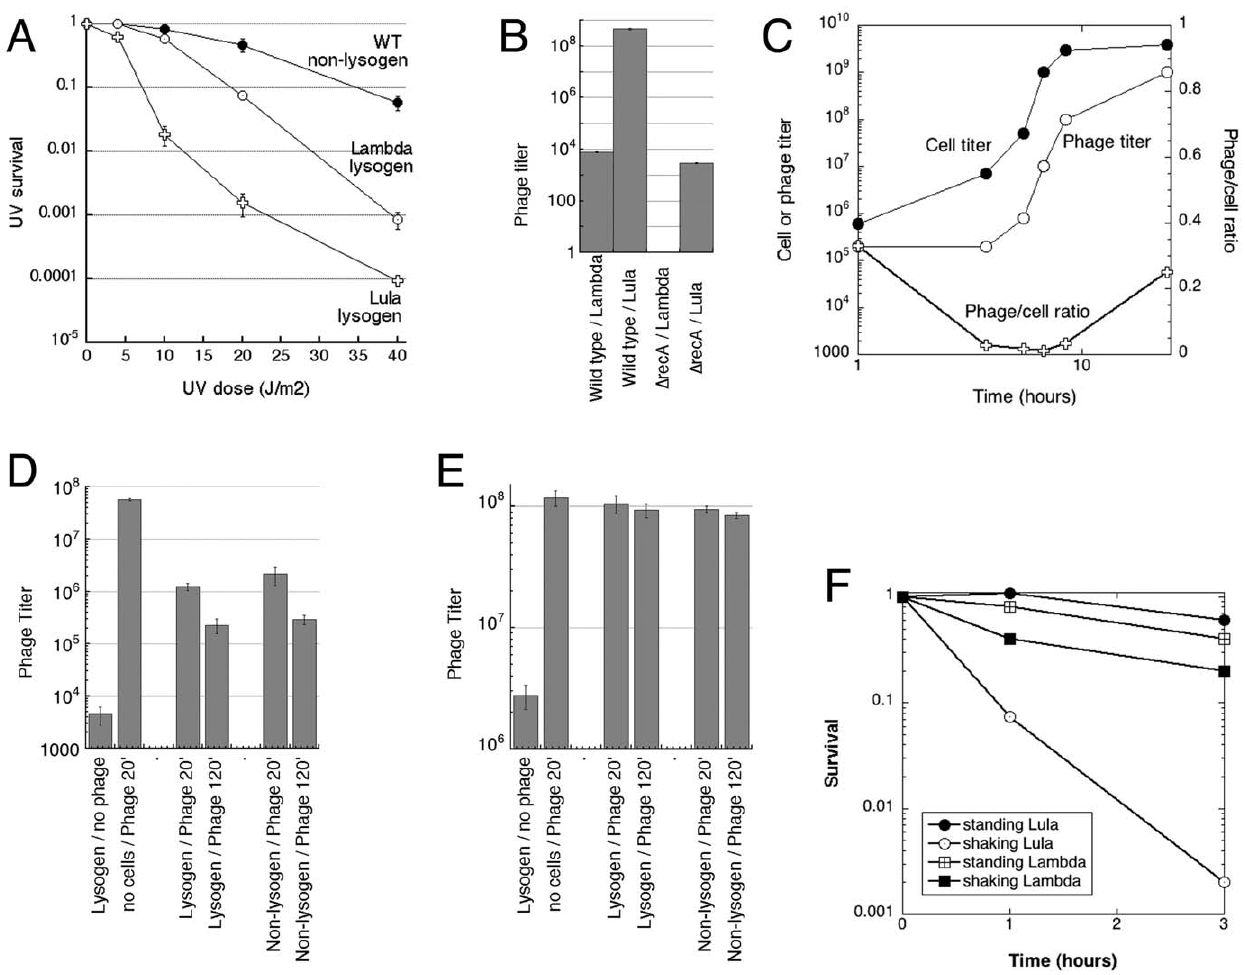
Figure 4. Testing possible explanations for high phage titer in cultures of Lula lysogens. A. UV-sensitivity of lysogens. Strains: wild type non-lysogen, AB1157; Lambda lysogen, EL104; Lula lysogen, EL103. The data points are means of 3–4 independent measurements, done on different days, 6 SEM. B. Phage titer in saturated cultures of wild type (EL103 and EL104) and D recA lysogens (Lula, EL105; Lambda, EL106). The data points are means of five independent measurements, done on the same day, 6 SEM. C. Cell titer versus Lula titer in the culture of a Lula lysogen (EL103) as a test for possible quorum sensing. Note that X axis is in log scale, as the left Y axis, but the right Y axis (for the lower curve) is linear. D. Stability of Lambda in saturated cultures of Lambda lysogen (EL104) and non-lysogen (AB1157). The data points are means of 3 independent measurements, done on different days, 6 SEM. E. Stability of Lula in saturated cultures of Lula lysogen (EL103) and non-lysogen (AB1157). The data points are means of 3 independent measurements, done on different days, 6 SEM. F. Stability of Lambda and Lula against aerosolation. The loss of phage titer in either stationary or rapidly shaking (to generate frothing) 1% NaCl suspensions was determined at two time points.